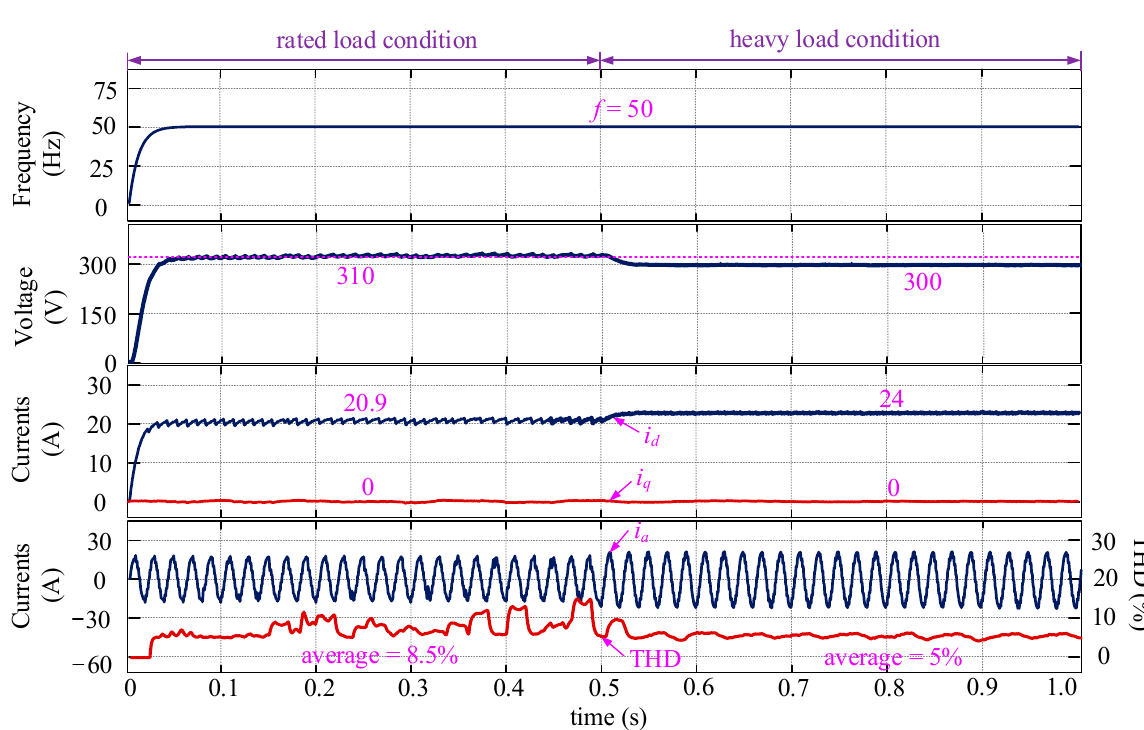
Figure 14. Control performance of the proposed DCL method with parameter mismatch considered (the SMDO works, L f_mea = 4 L f , L l_mea = 3 L l , R f_mea = 0.5 R f , R l_mea = 0.3 R l ).